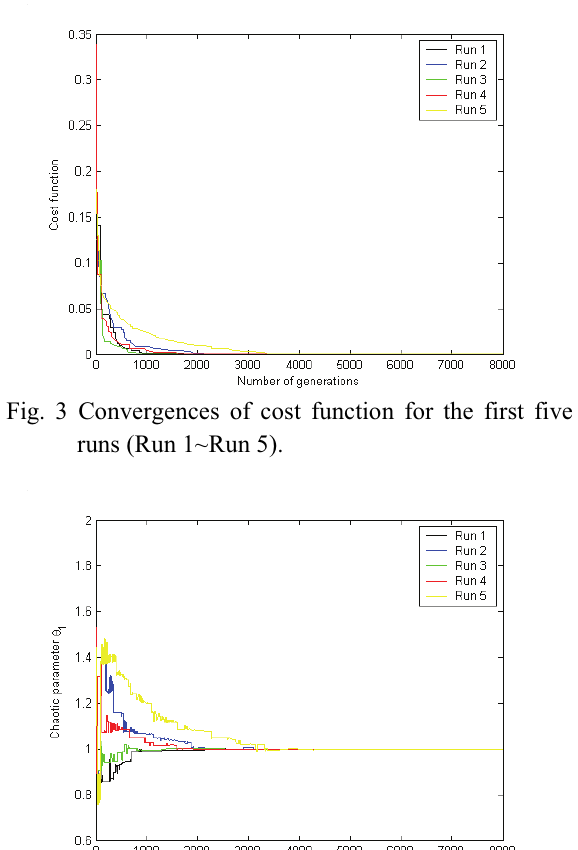
Fig. 5 Convergences of parameter runs (Run 1~Run 5).